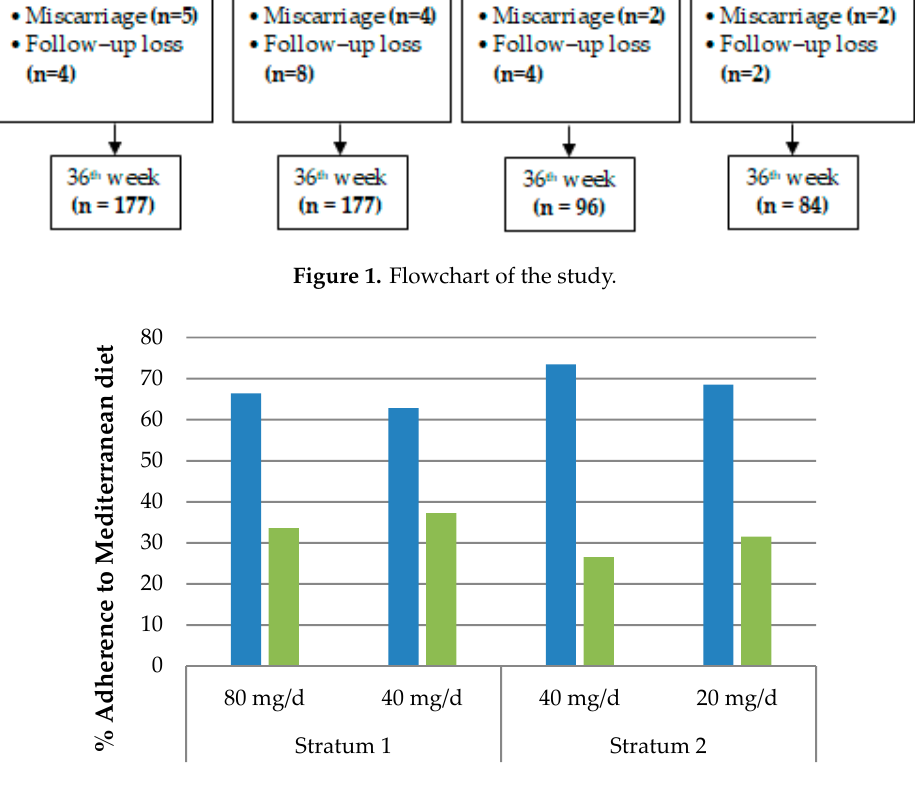
Table 1. Baseline characteristics of the study population.